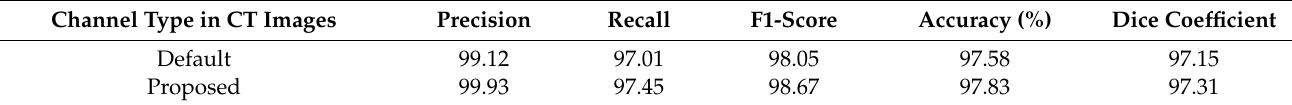
Table 2. Impact of CT image channels on system performance.